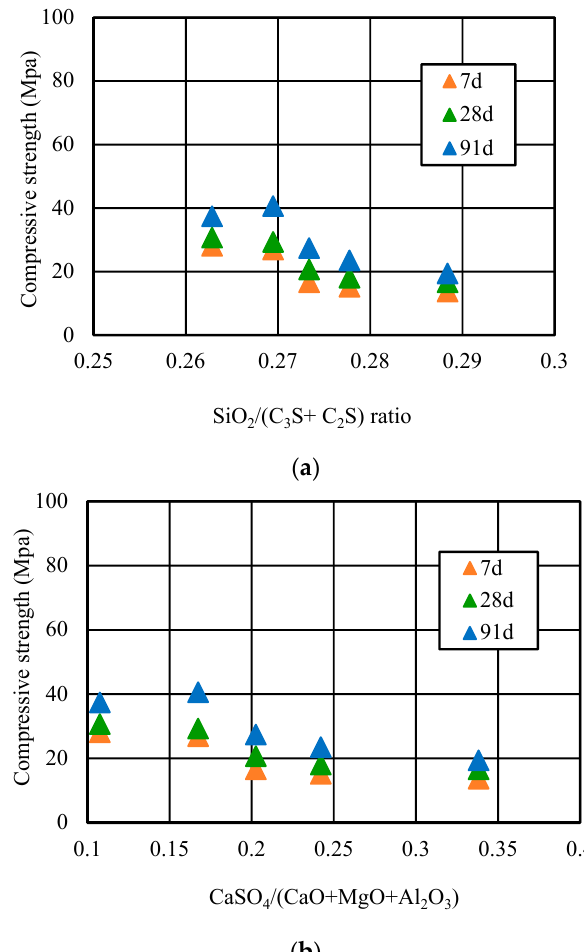
/ (C + C 2 2 S 3 S) and ( b ) CaSO 4